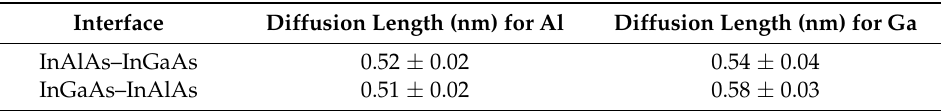
Table 3. Diffusion lengths obtained by fitting Fick’s second law to Al and Ga concentration profiles in the thick-motif sample (Table 2), not accounting for the 10% discrepancy between HRXRD and APT SL period